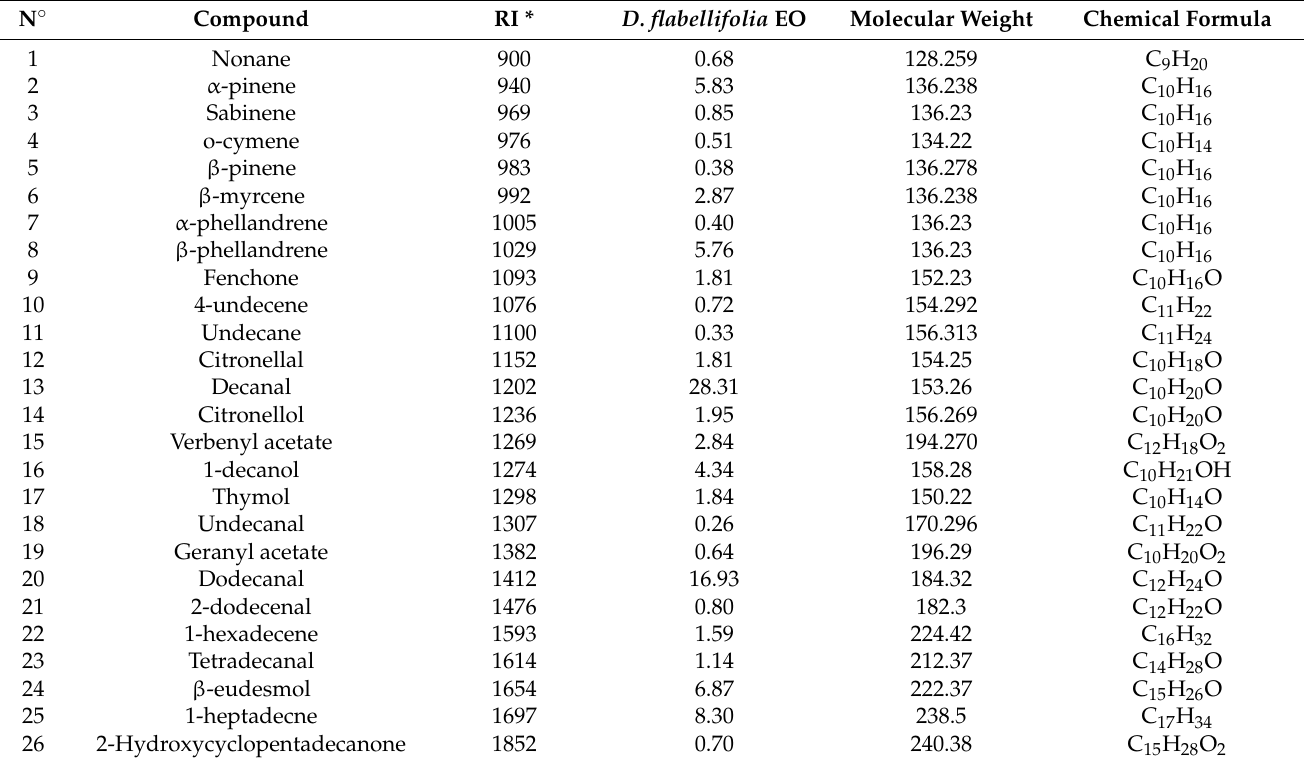
Table 1. Chemical composition of D. flabellifolia aerial parts identified by GC-MS